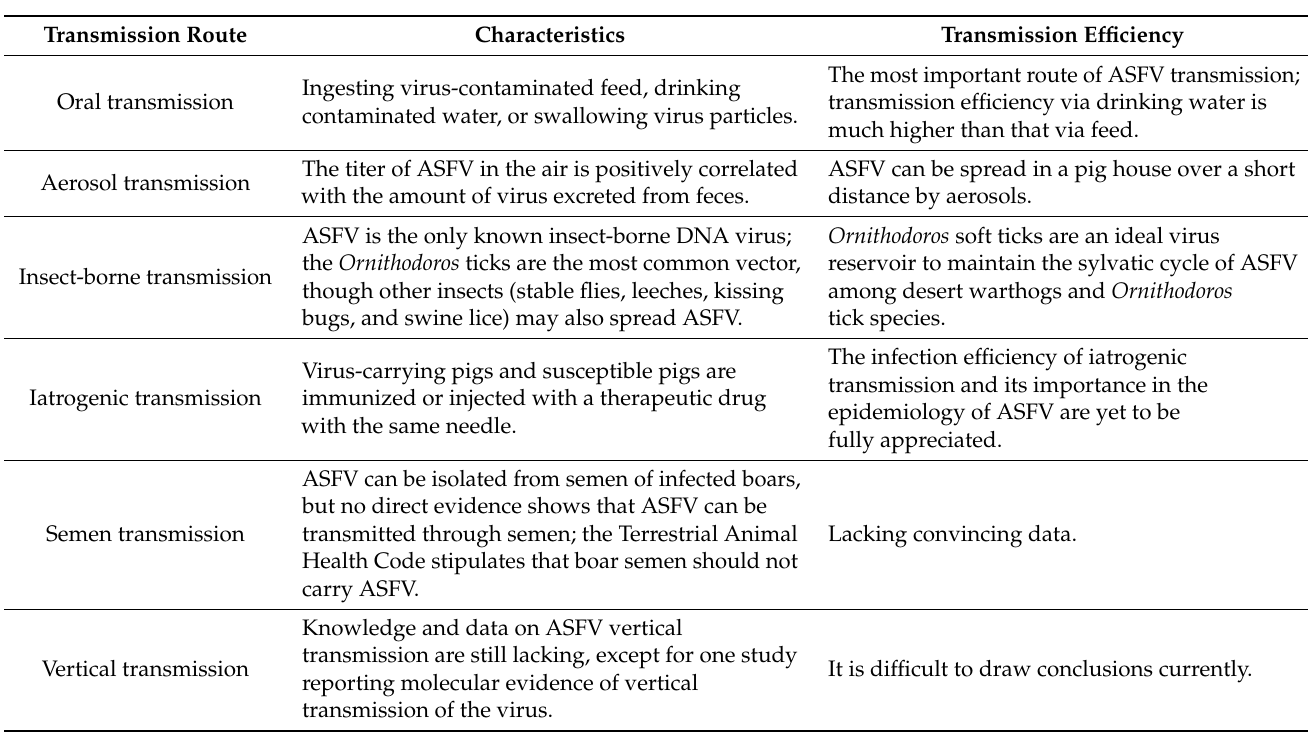
Table 1. Different routes of ASFV transmission and their characteristics and transmission